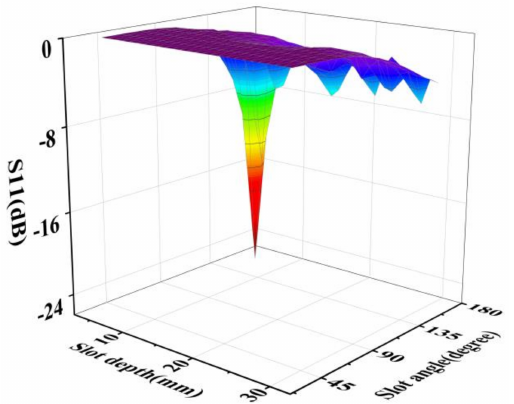
Figure 6. S11 simulation results of coaxial slot radiator for different values of slot depth and slot